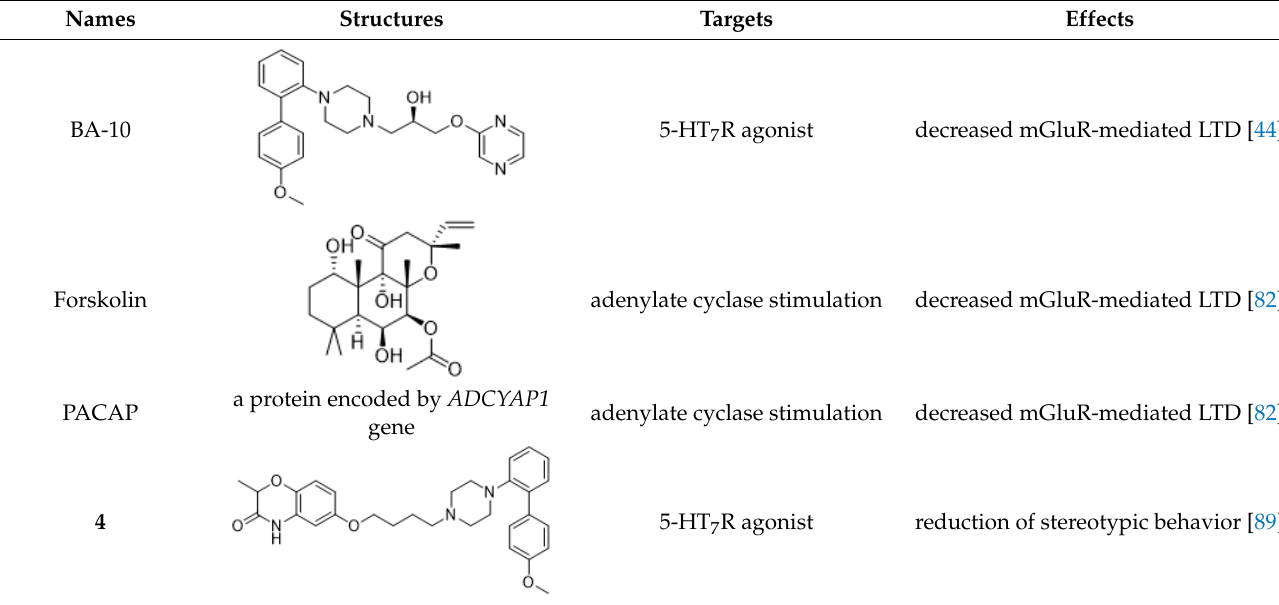
Table 2. Pharmacological agents which have potential effects on FXS treatment.